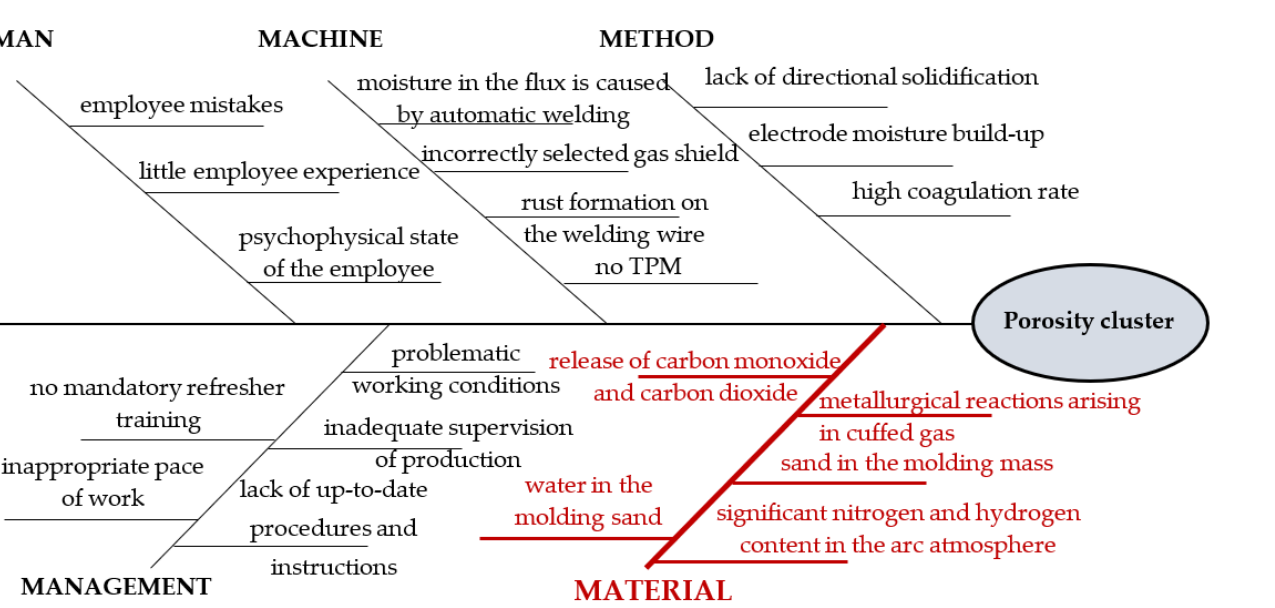
Figure 6. Fragment of the Ishikawa diagram for the “ material ” category. Potential causes, i.e., water in the molding mass, were considered as one potential cause. This was due to the same second-order causes identified for them. For each